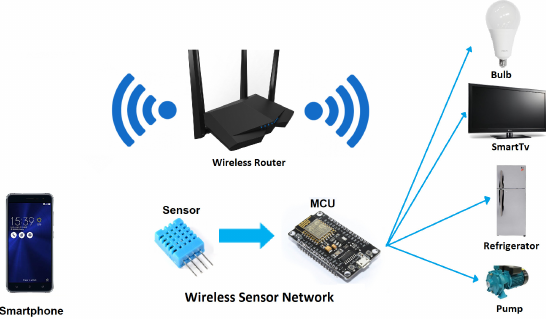
Figure 4. Wi-Fi peer-to-peer and Direct